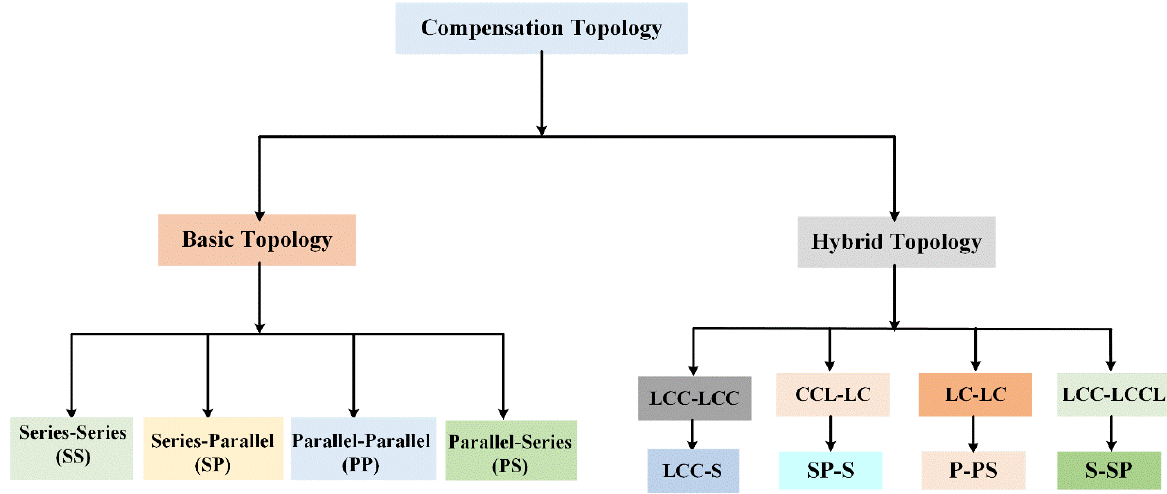
Figure 2. Classifications of compensation